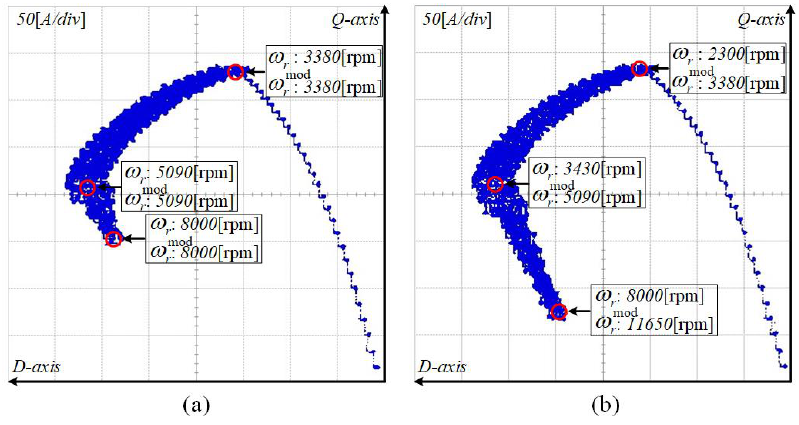
Figure 7. d -/ q -axis currents trajectory for maximum torque driving with different DC-link voltages: ( a ) DC-link voltage of 380 V and ( b ) DC-link voltage of 260